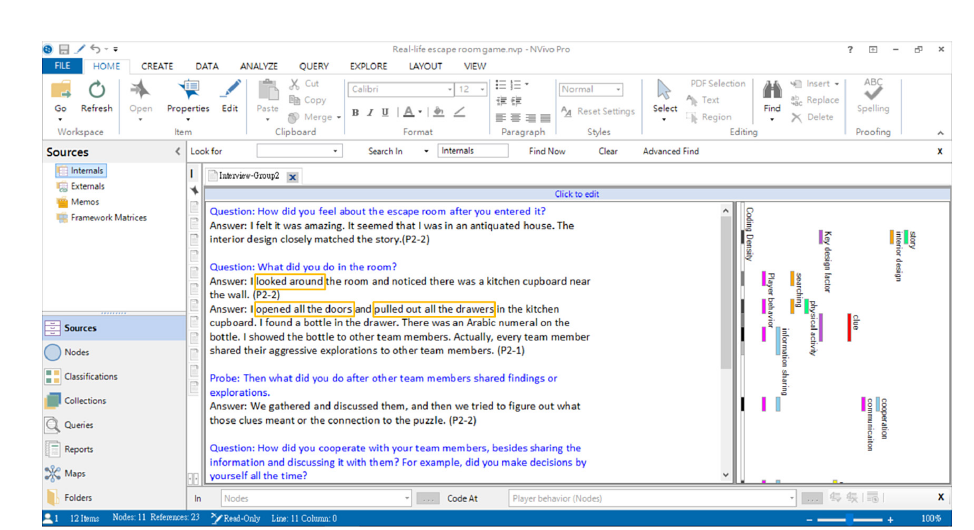
Figure 2. Example of a participant’s response and code